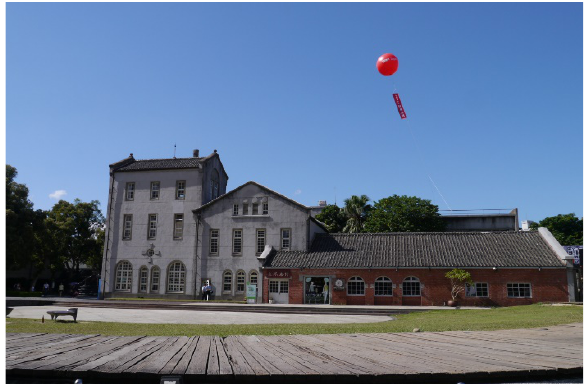
Figure 8: Taipei Huashan 1914 Creative Park.